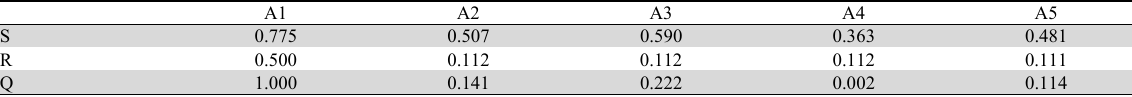
The measures' S, R and Q values